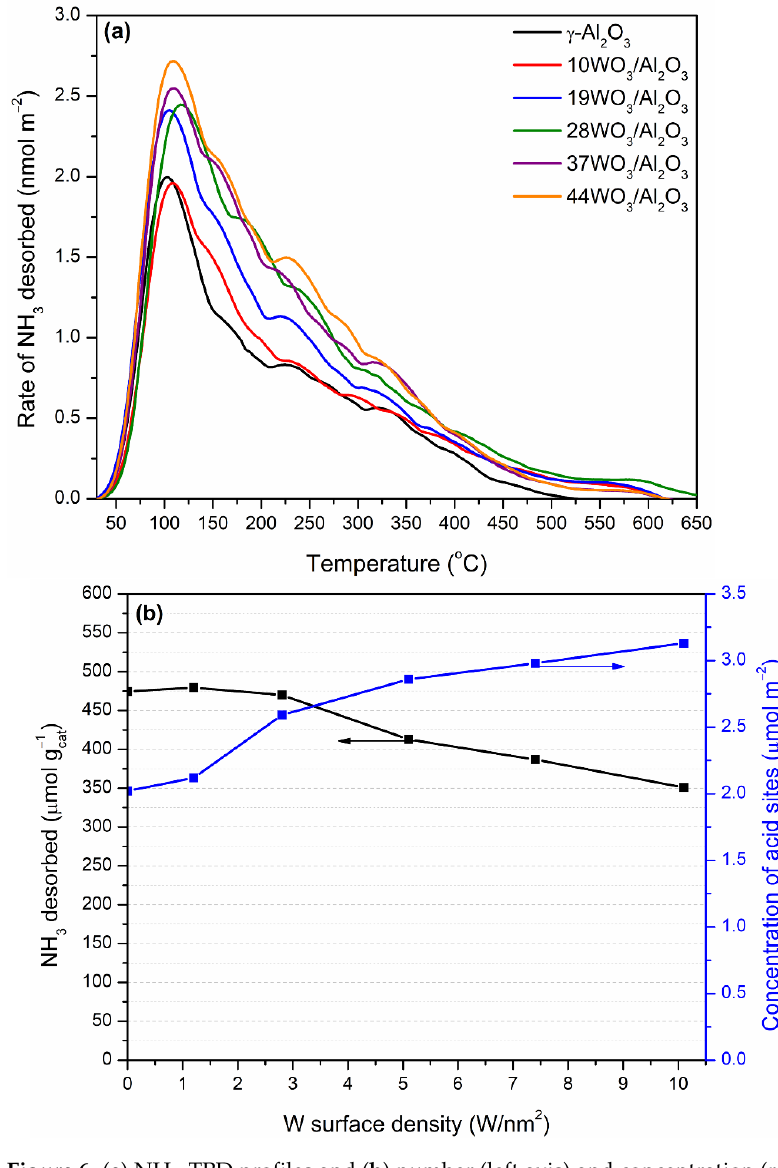
Figure 6. ( a ) NH 3 -TPD profiles and ( b ) number (left axis) and concentration (right axis) of total acid sites of the WO 3 /Al 2 O 3 catalysts.